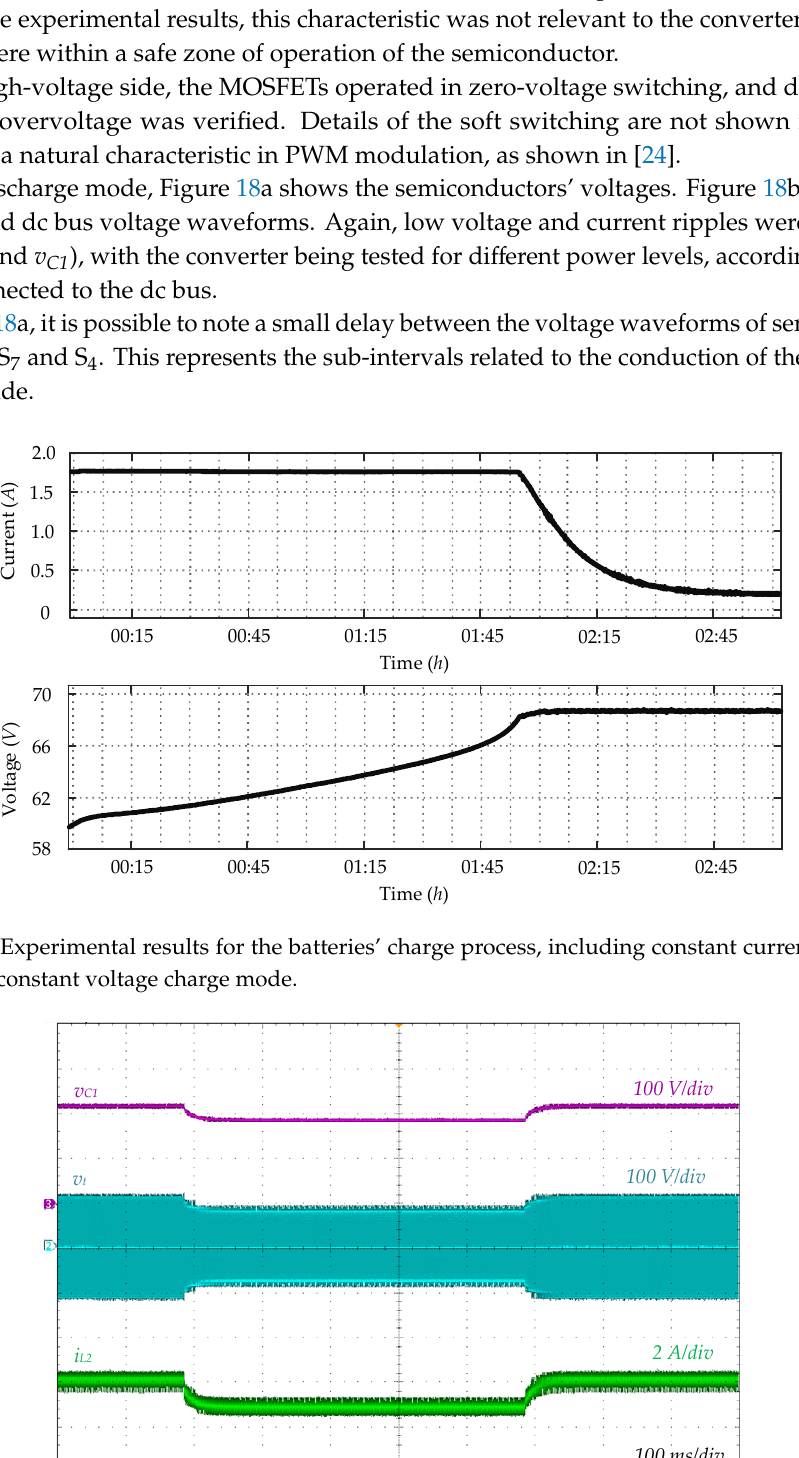
Figure 16. Closed-loop response of converter CFDAB controlling the dc bus voltage.